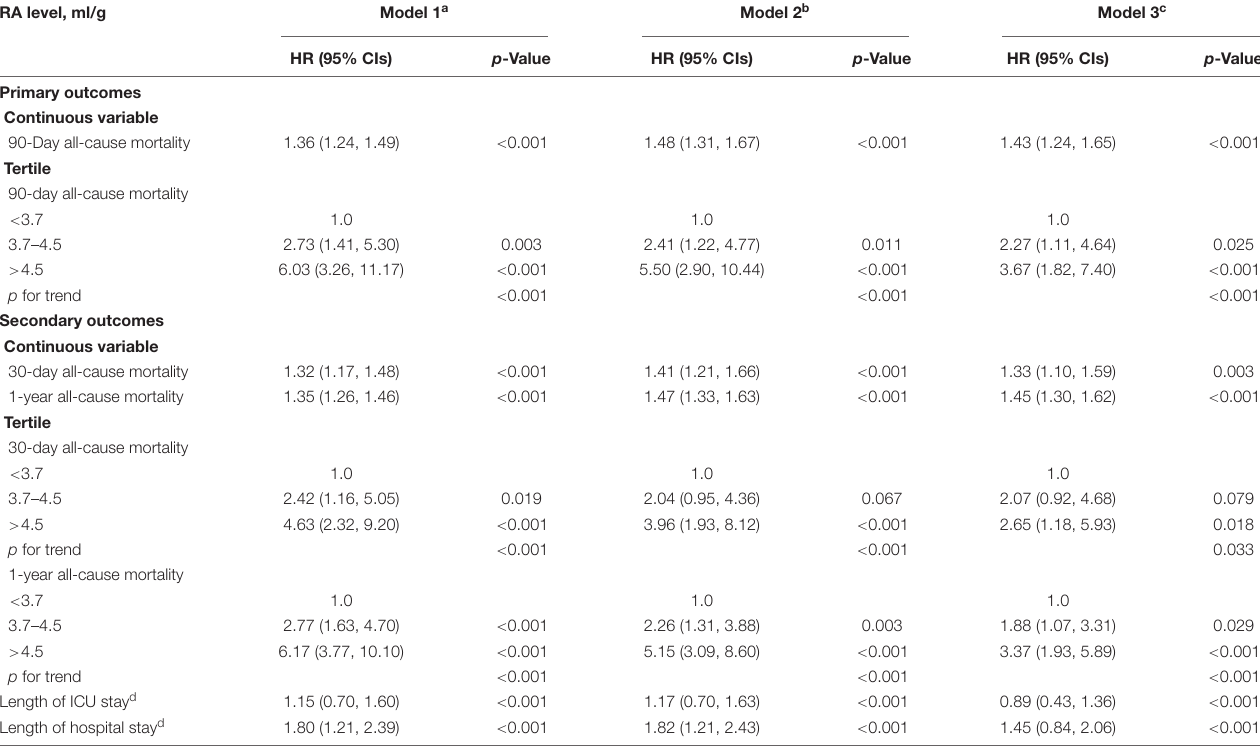
TABLE 2 | Hazard ratio (HR) [95% confidence intervals (CIs)] for all-cause mortality across groups of ratio of red blood cell distribution width (RDW) to albumin (RA)